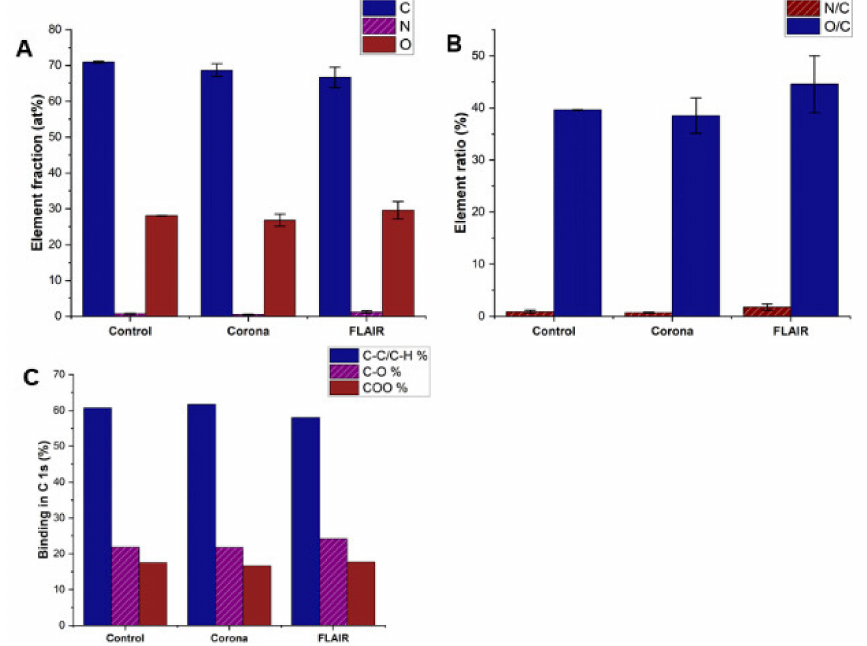
Figure 4. XPS results of plasma treated and control PET samples: ( A ) Elemental fractions (at %),